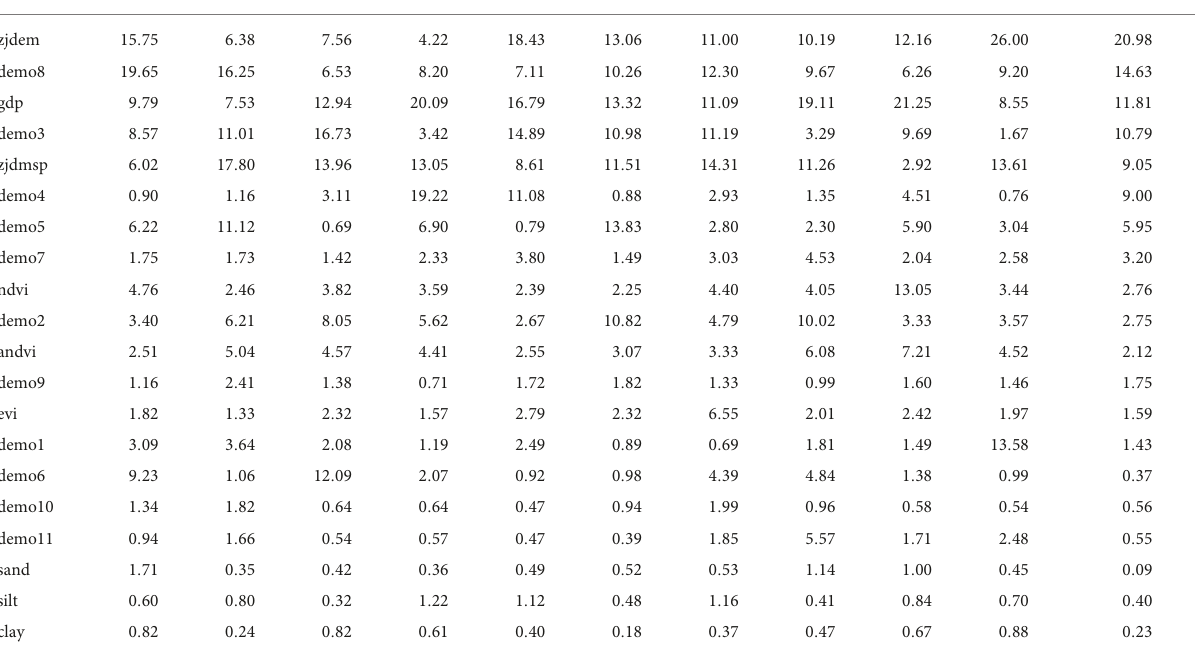
TABLE 1 The contribution of each variable to the final training MaxEnt